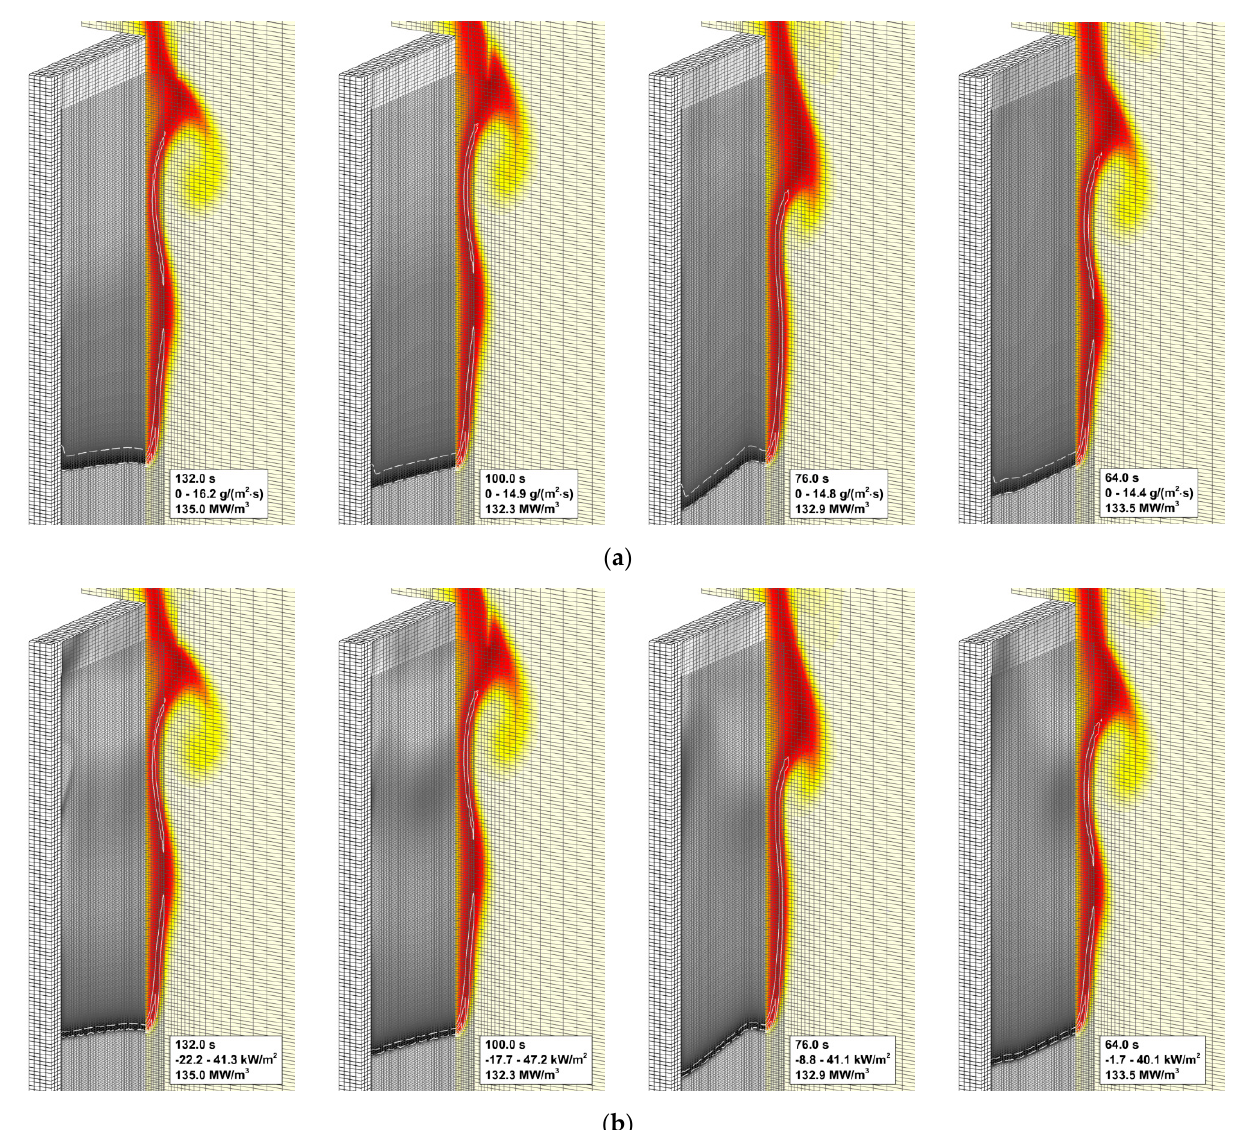
Figure 13. Instantaneous flame structure predicted with the different pre-exponential factors of volatile oxidation reaction rate. Left to right: the pre-exponential factor doubles. Solid lines: volumetric heat release rate in gaseous flame 20, 40, 60, 80, 100 MW/m 3 . ( a ) Burning rate at the sample surface. Dashed lines: mass loss rate 10 g/(m 2 ‧ s). ( b ) Net heat flux at the sample surface. Dashed lines: net heat flux 35 kW/m 2 .